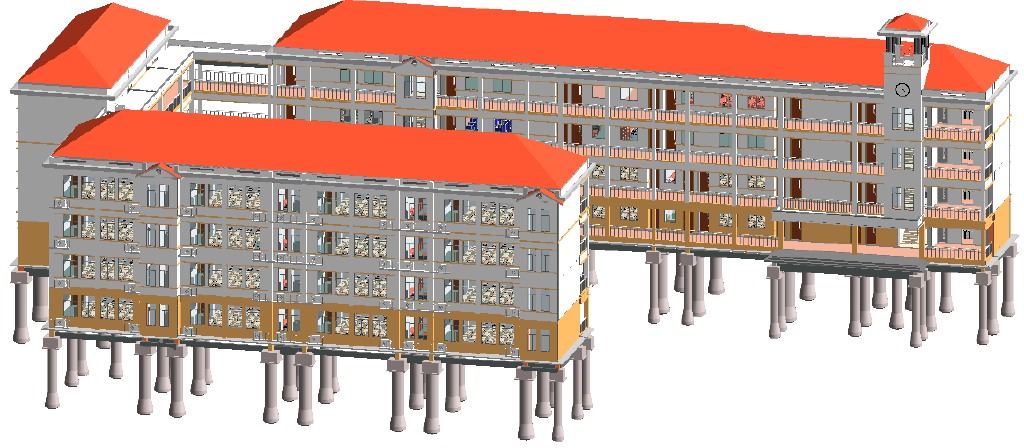
Figure 7. A 3D schematic of the studied education building. Table 2. Characteristics of the studied education building.